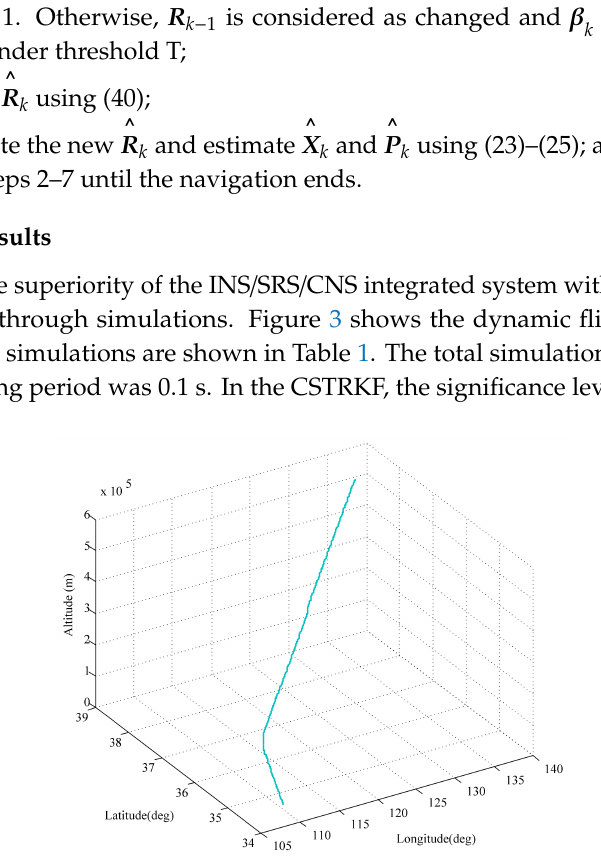
Figure 3. Dynamic flight trajectory of hypersonic cruise vehicles (HCVs). Table 1. Parameters of the